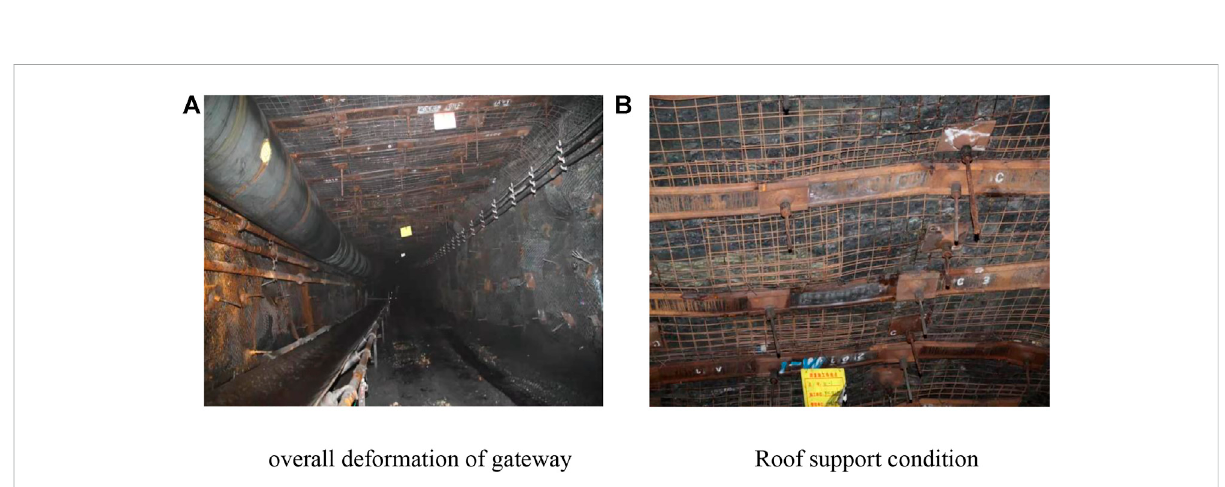
FIGURE 11 Deformation monitoring curve of underground gateway after hydraulic fracturing and pressure relief + high prestressed full cable support ” technology. (A) “ Hydraulic fracturing and pressure relief + high prestressed full cable support ” technology. (B) " High prestressed full cable support ” technology.